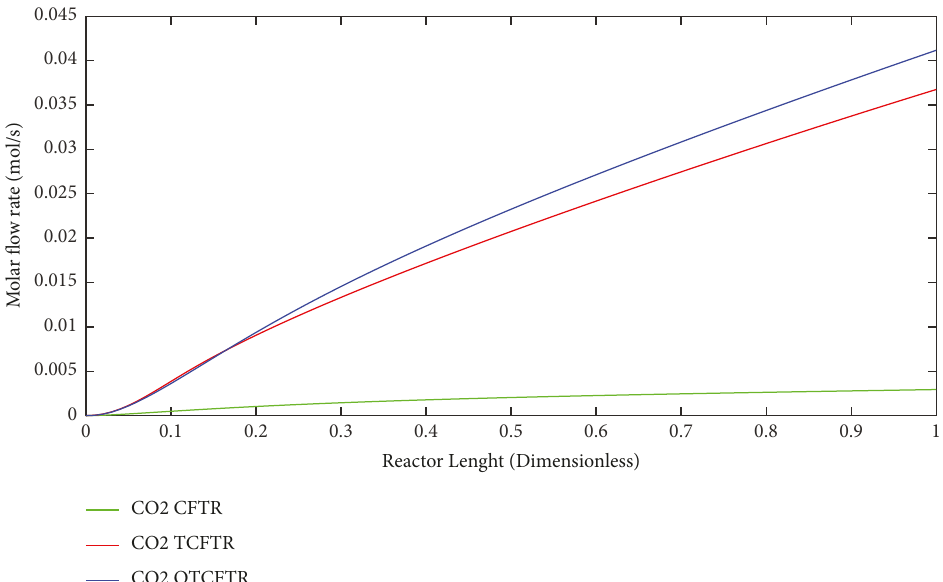
Figure 19: Comparison of the molar flow rate of CO in the exothermic part of the reactor for CFTR, TCFTR, and OTCFTR